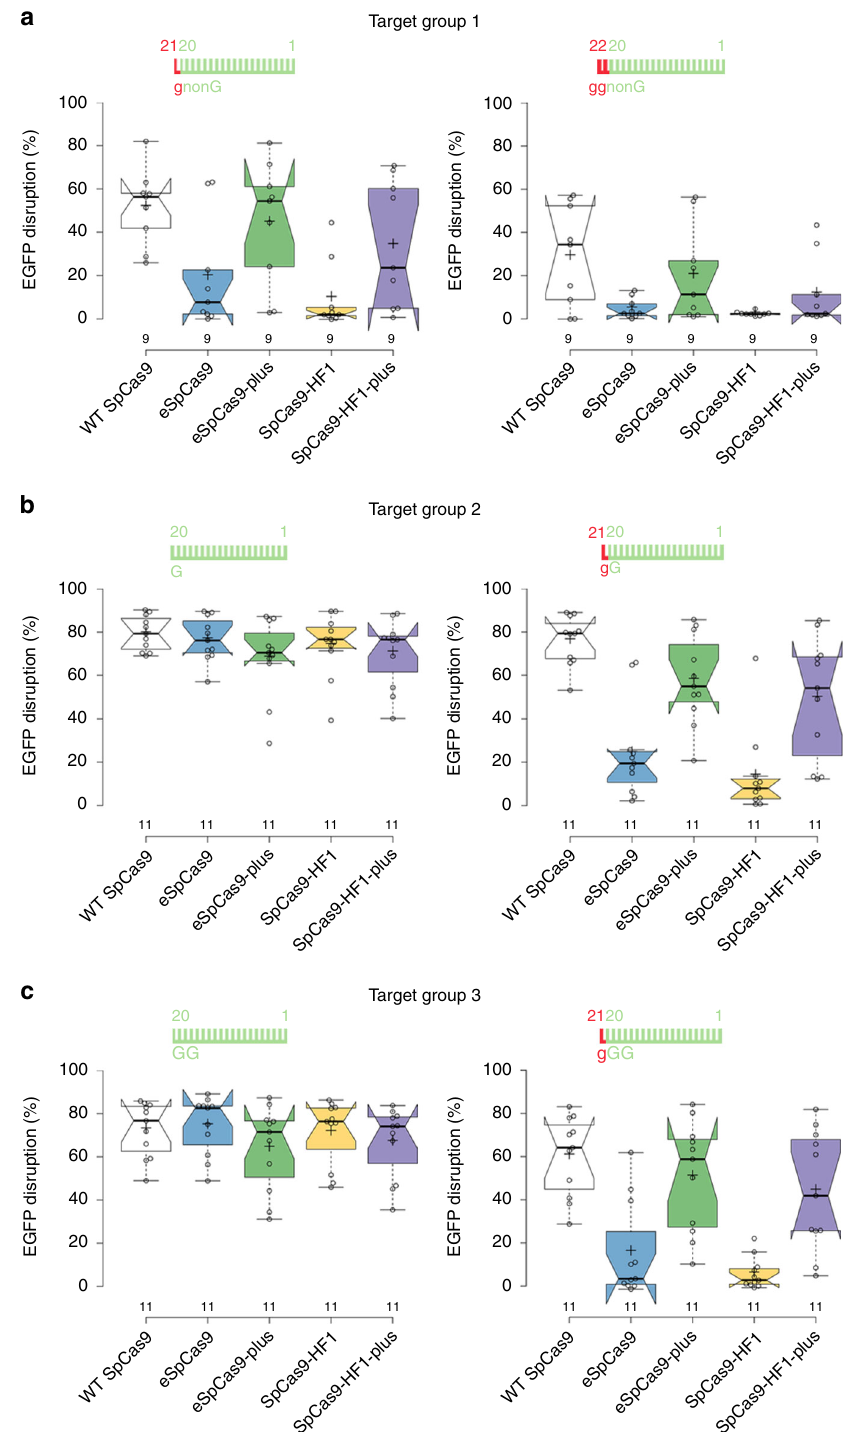
Fig. 6 The plus variants are effective when transfected in pre-assembled RNP form. a – c EGFP-disruption assays. Target sequences start with 5 ′ non-G-, G- or GG-nucleotides. Data from the individual samples are detailed in Supplementary Fig. 8c – e. Tukey-type boxplots by BoxPlotR 60 : center lines show the medians; box limits indicate the 25th and 75th percentiles; whiskers extend to the “ minimum ” and “ maximum ” data situated within 1.5 times the interquartile range from the 25th and 75th percentiles, respectively; notches indicate the 95% con fi dence intervals for the medians; crosses represent sample means; data points are plotted as open circles representing the mean of biologically independent triplicates. Spacers are schematically depicted beside the charts as combs: green color teeth indicate matching-, while a red color tooth indicates the presence of an appended nucleotide within the spacer; numbering of tooth position corresponds to the distance of the nucleotide from the PAM; the starting 20th nucleotide or dinucleotide of the spacer is indicated by an uppercase letter and an appended 21st and 22nd nucleotides by red lowercase letters. See also Supplementary Fig.